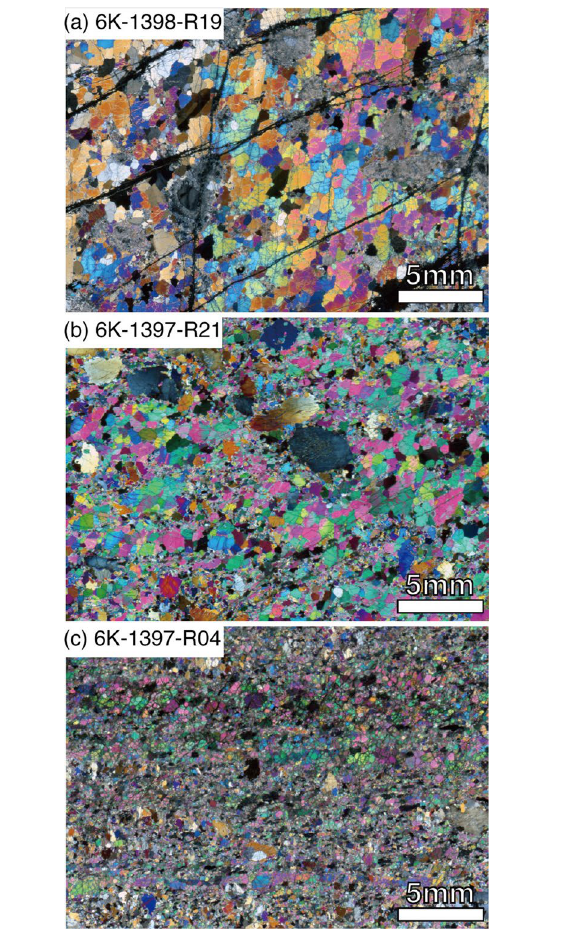
Fig. 4 Photomicrographs (cross‑polarized light) of representative peridotites from site 1 on XZ section. a Coarse‑grained texture. b Heterogeneous intermediate texture. c Fine‑grained